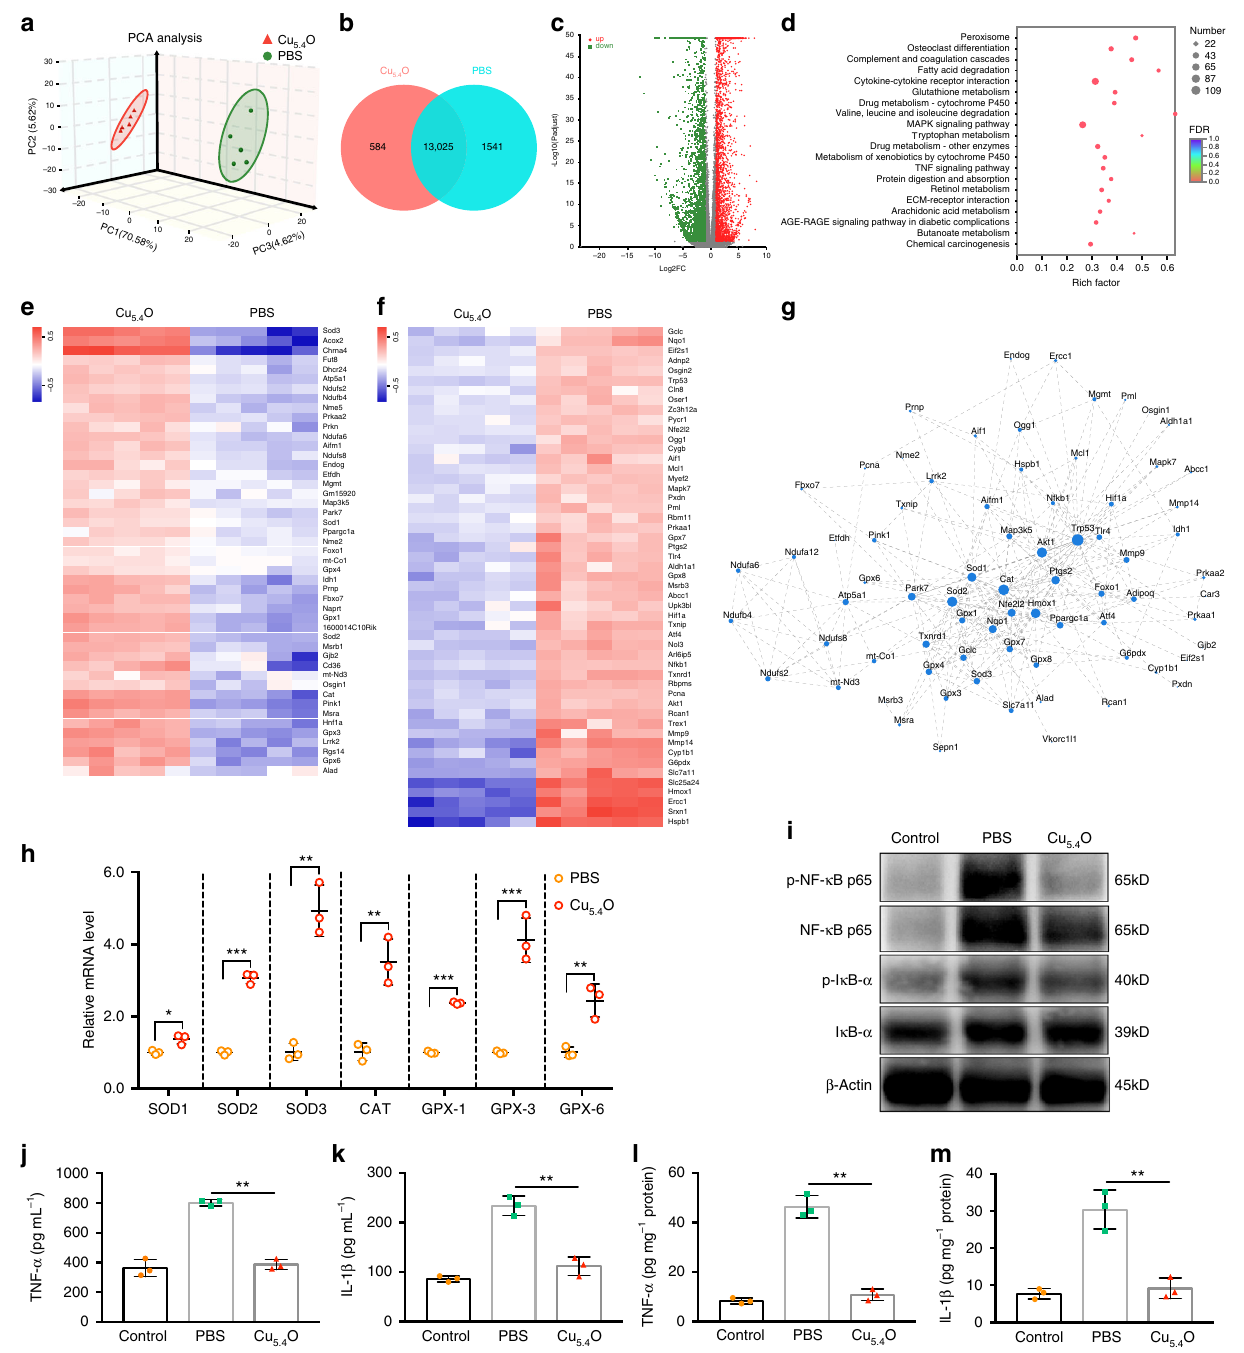
Fig. 9 Therapeutic mechanisms of Cu 5.4 O USNPs on AKI. a Principal component analysis (PCA) was performed based on differentially expressed genes from the kidneys of two groups. Each data point corresponds to the PCA analysis of each sample. b Venn diagram of the transcriptomic pro fi les between Cu 5.4 O USNPs and PBS groups. c Volcano plots showing the identi fi ed upregulated and downregulated genes by Cu 5.4 O USNPs. d KEGG pathway enrichment analysis of the identi fi ed differentially expressed genes. The 20 most signi fi cantly enriched pathways are shown. Heat maps of signi fi cantly e upregulated and f downregulated genes involved in the oxidative stress after Cu 5.4 O USNPs treatment (fold change ≥ 2 and P < 0.05). g Protein – protein interaction network of differentially expressed genes involved in the oxidative stress. h qRT-PCR analysis of the mRNA expression levels of antioxidant genes. i Western blot analysis of the expression of phospho-NF- κ B p65, total NF- κ B p65, phospho-I κ B- α , and total I κ B- α in kidney tissues of AKI mice. Serum levels of j TNF- α and k IL-1 β . Renal levels of l TNF- α and m IL-1 β . In h , j – m , data represent means ± s.d. from three independent replicates, and P values were calculated by Student ’ s t -test ( h ) and one-way ANOVA ( j – m ). * P < 0.05; ** P < 0.01; *** P < 0.001. Source data are provided as a Source Data fi